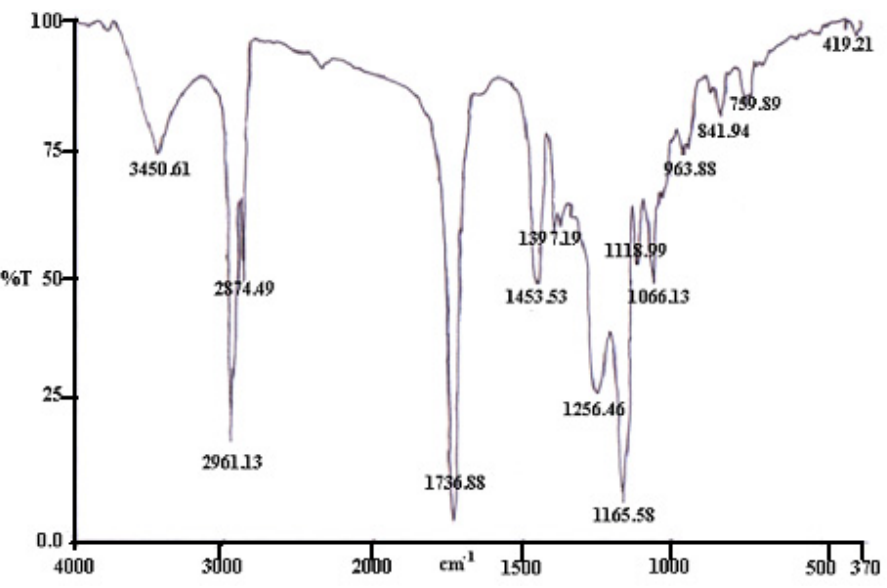
Figure 1. FTIR spectrum of acrylic microspheres.